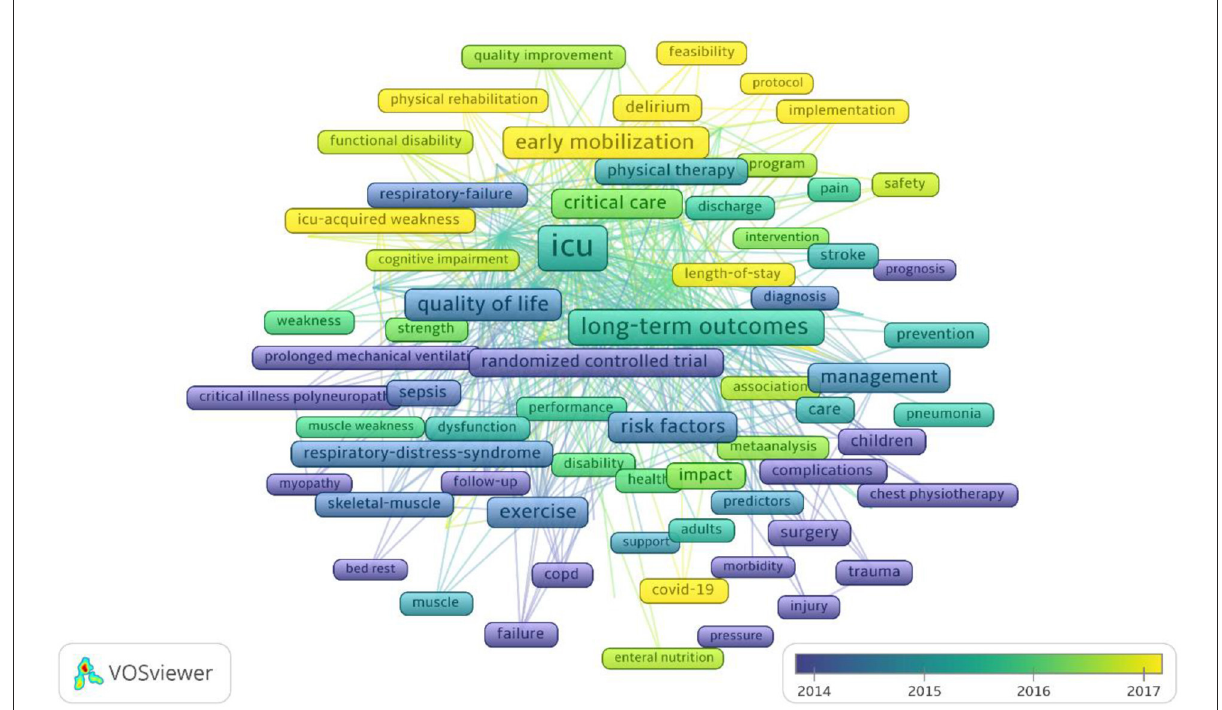
FIGURE6 Distribution of keywords according to the average publication